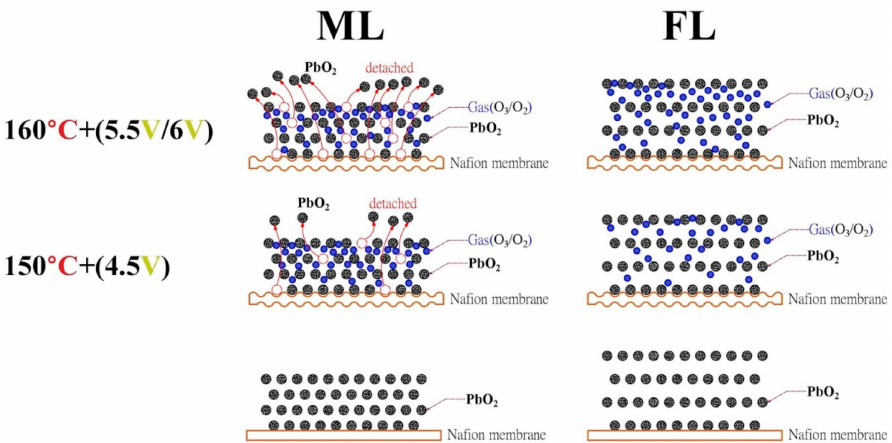
Figure 9. Structural simulation after accelerating test for ML (left) and for FL